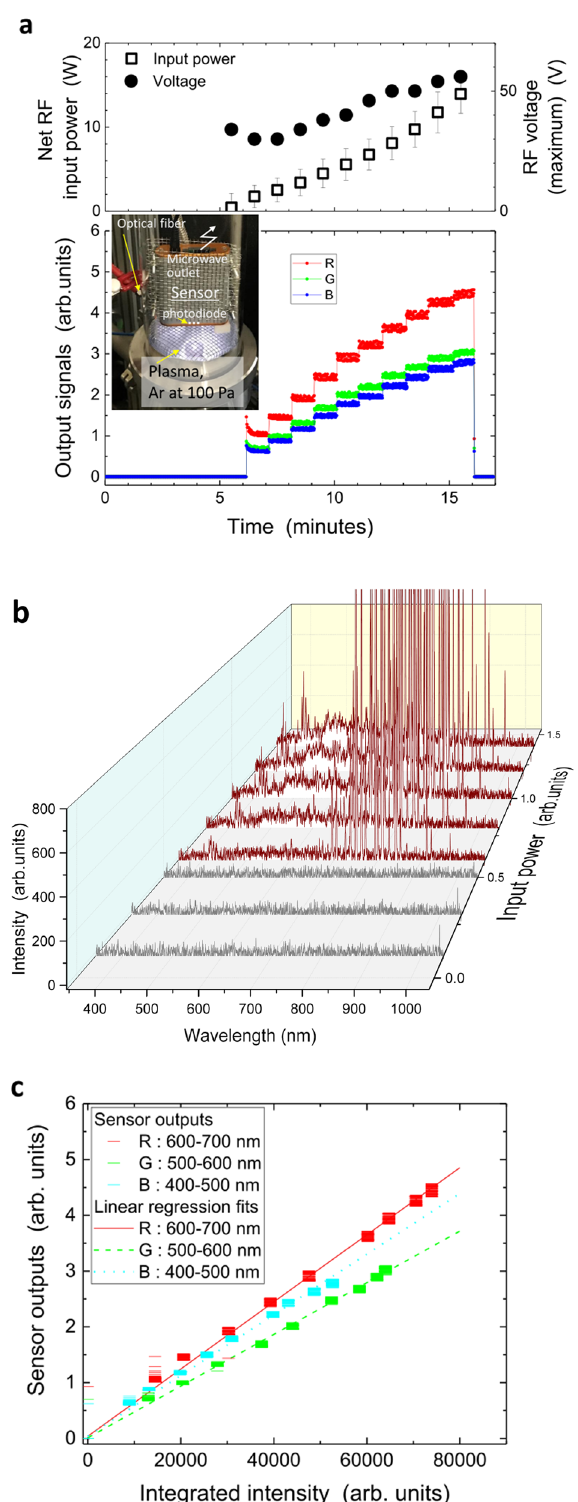
Figure 3. Detection of plasma emissions at 100 Pa of Ar. (a) Time evolutions of signals of averaged radiofrequency (RF, 13.56 MHz) net input power for plasma generation with the corresponding peak RF amplitude (upper side) and R, G, and B outputs of the sensor located in the vicinity of the plasma region (lower side), recorded on a personal computer located outside the vacuum chamber. Input power is linearly elevated every minute, and the power at level six ignites plasma. The inset photograph shows the outlook of the vacuum chamber used here and the visible plasma image. (b) Emission spectra of plasma monitored by monochromator to which optical fibre transmits lights from other end located just outside of glass vessel. Spectrum examples before plasma ignition are in grey, whereas those after plasma ignition are in brown, and lower-level signals are enlarged to focus on intensities in the visible light range. (c) Comparison of sensor output signals with integrated intensities of spectra monitored by monochromator. The signals used here are shown in (a)